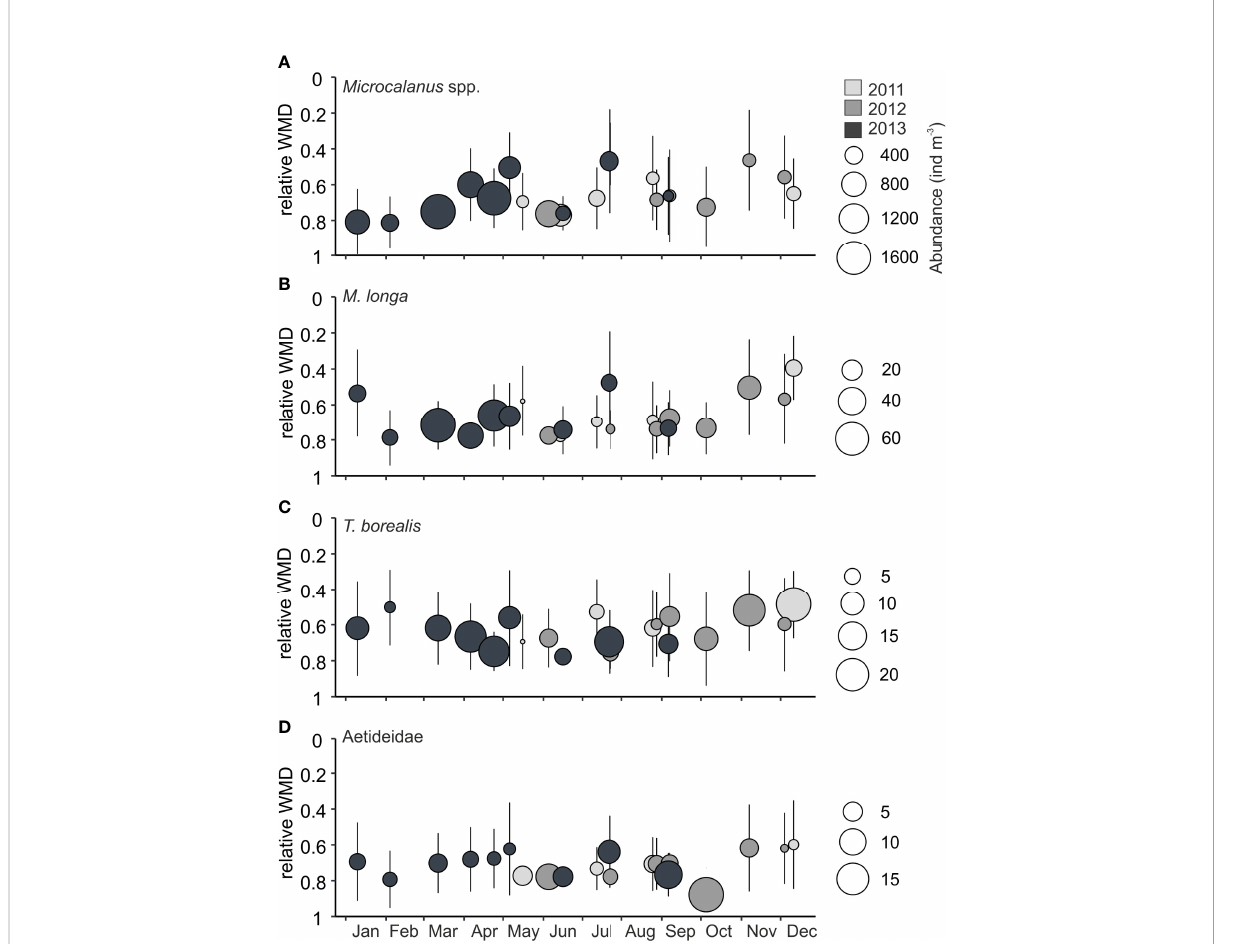
FIGURE 7 Relative weighted mean depths (WMDs) of taxa with deep distribution in Billefjorden, years 2011-2013. Error bars indicate the spread (Z s ) of individuals over the water column, bubble size re fl ects mean abundance in water column (ind m − 3 ), and color indicates year. (A) Microc alanus spp., (B) Metridia longa , (C) Triconia borealis , and (D) Aetideidae. Note the differences in scale between species.The relative WMD is the ratio of WMD to the total sample depth, i.e., a WMD of<0.5 indicates that the taxa was centered in the upper half of the water column, and a WMD closer to 1 indicates that the distribution was centered in the deeper part of the water